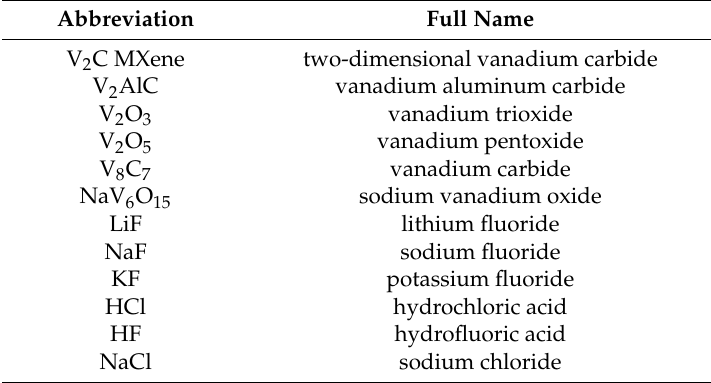
Table 1. Abbreviations and the corresponding full names of chemical